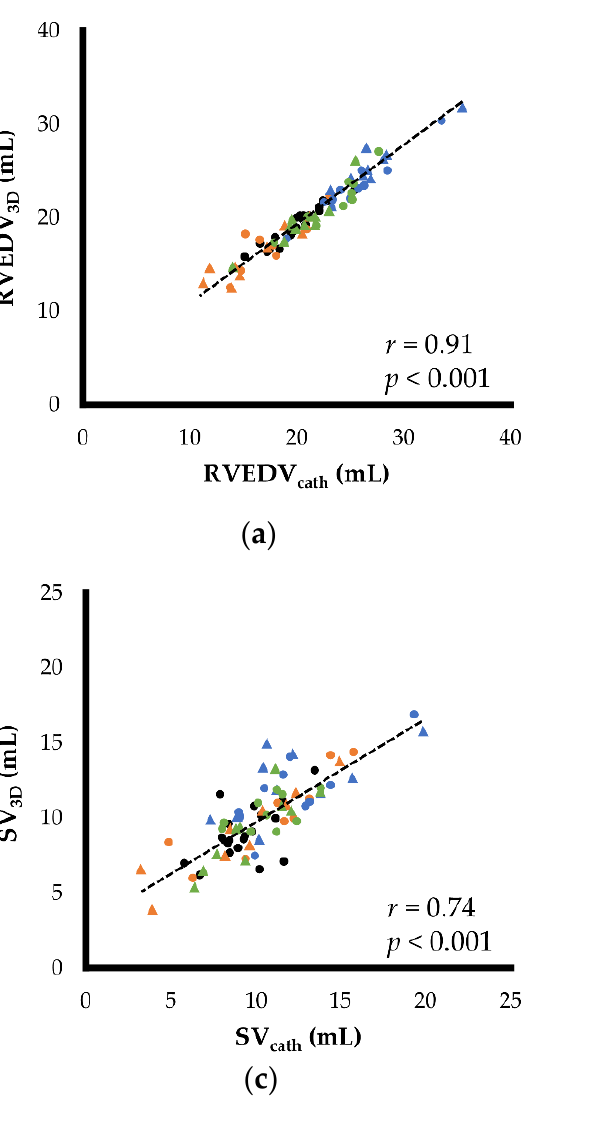
( d ) Figure 3. Agreements between the right ventricular morphology and function measured by right heart catheterization and real-time three-dimensional echocardiography demonstrated on Bland– Altman plots: ( a ) end-diastolic right ventricular volume (RVEDV); ( b ) end-systolic right ventricular volume (RVESV); ( c ) stroke volume (SV); ( d ) ejection fraction (EF). The horizontal solid and dotted lines represent the mean difference and the limits of agreement, respectively. Black round dots show the measurements of baseline. Orange round and triangular dots show the measurements of 5 and